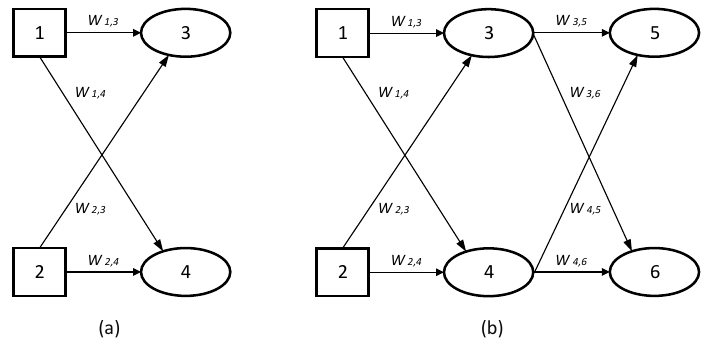
Figure 1. ( a ) Simple neural network with two input nodes and two output nodes. ( b ) Simple neural network with two input nodes, one hidden layer with two nodes and two output